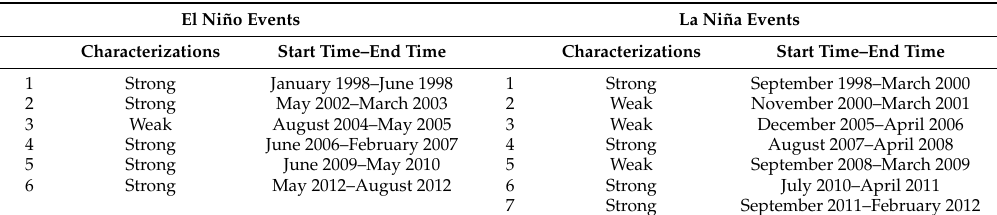
Table 2. El Niño and La Niña events’ characterizations during the period of January 1998 to December